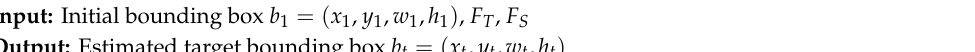
Algorithm 1 Outline of our proposed tracking